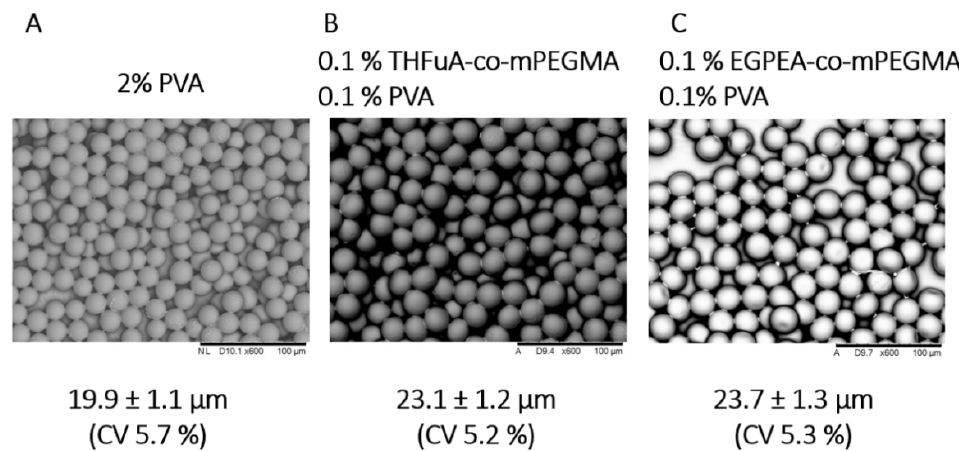
Figure 3. SEM images of particles produced using a droplet microfludics approach ( A – C ). Particles were manufactured with either PVA surfactant alone or with either of the bespoke surfmers THFuA-co-mPEGMA or EGPEA-co-mPEGMA with a weak 0.1% ( w / v ) PVA solution. Particles shown at 600× magnification. Particles were shown to be slightly agglomerated, which is due to the collection